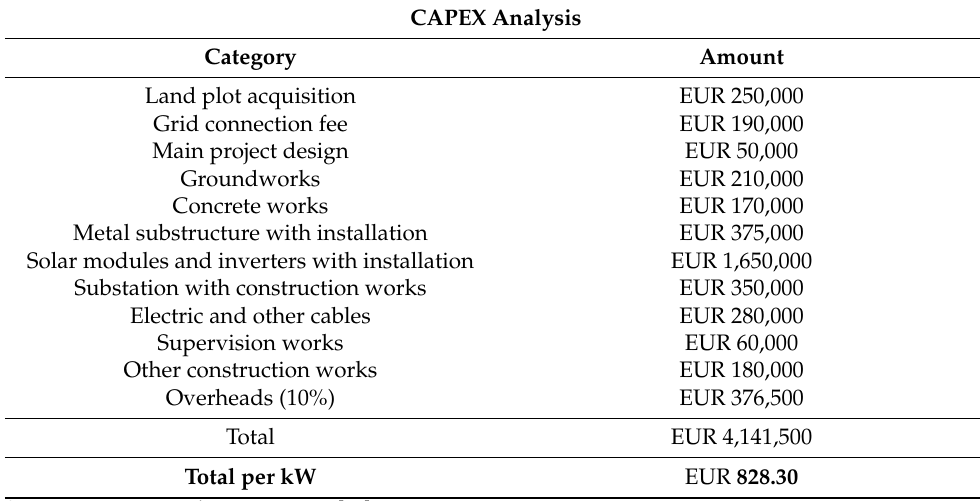
Table 1. Capital expenditures for the 5 MW solar power plant.